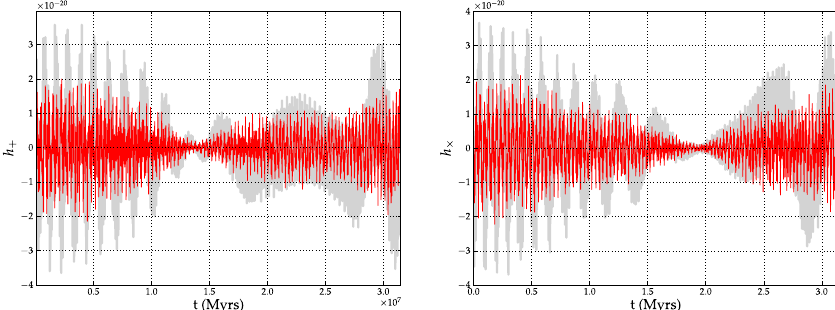
Fig. 52 Waveforms of a normal EMRI and a TSEMRI (see text) superimposed for a full year of data before the final plunge, which has been defined to happen at a periapsis of r plunge ≡ 2 × r ISCO , with r ISCO the radius of the innermost stable circular orbit, which is ∼ 8 M in this case. The mass of the central MBH is 3 × 10 6 M (cid:2) , the mass of the star 0 . 53 M (cid:2) . The spin of the MBH is set to a = 0 . 5 M and we neglect the spin of the